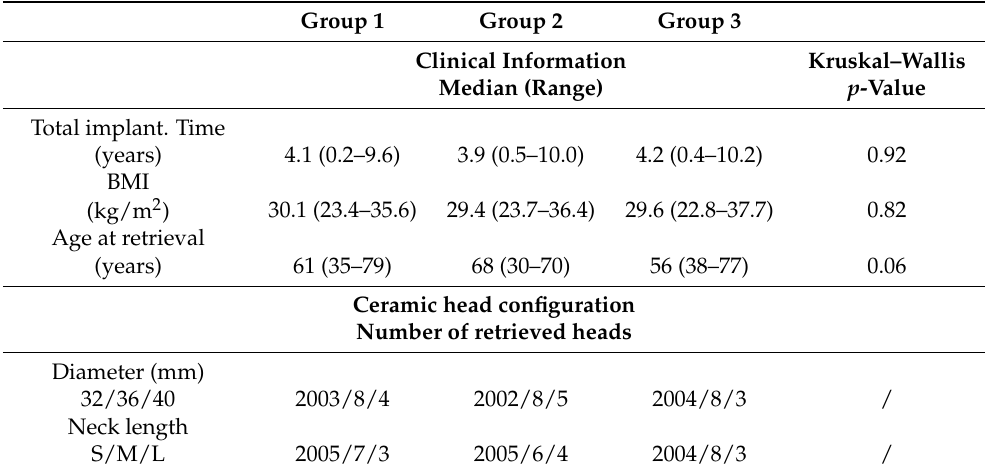
Table 1. Clinical information and ceramic head configurations. Further details are available in the Supplementary Materials (Figure S2 and Table